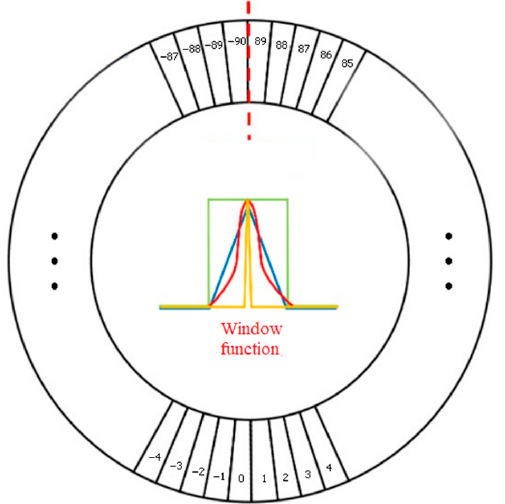
Figure 5. Circular smooth label.